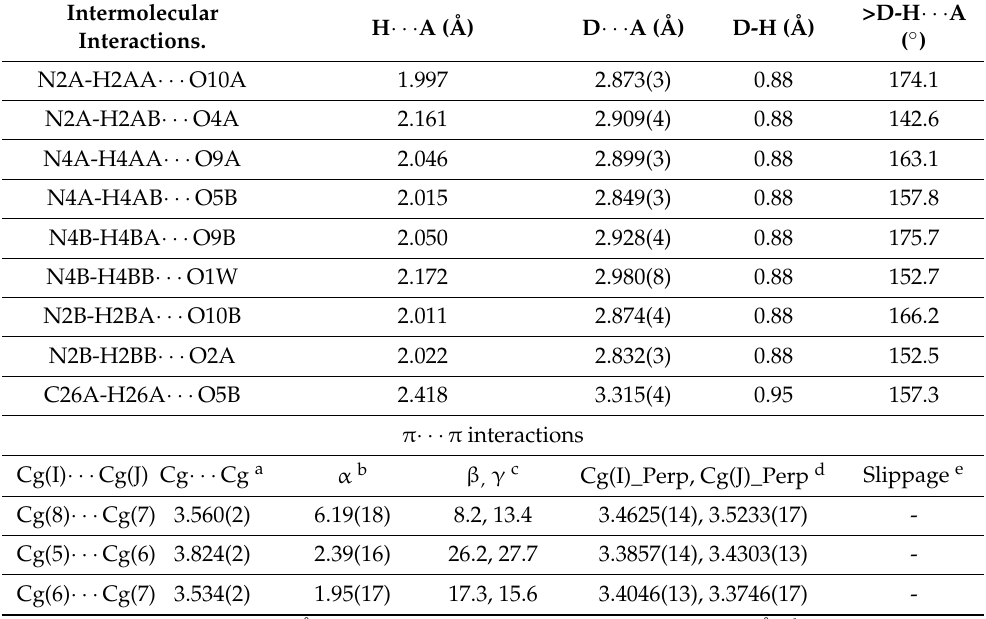
Table 7. Intermolecular interactions in 4 . Intermolecular